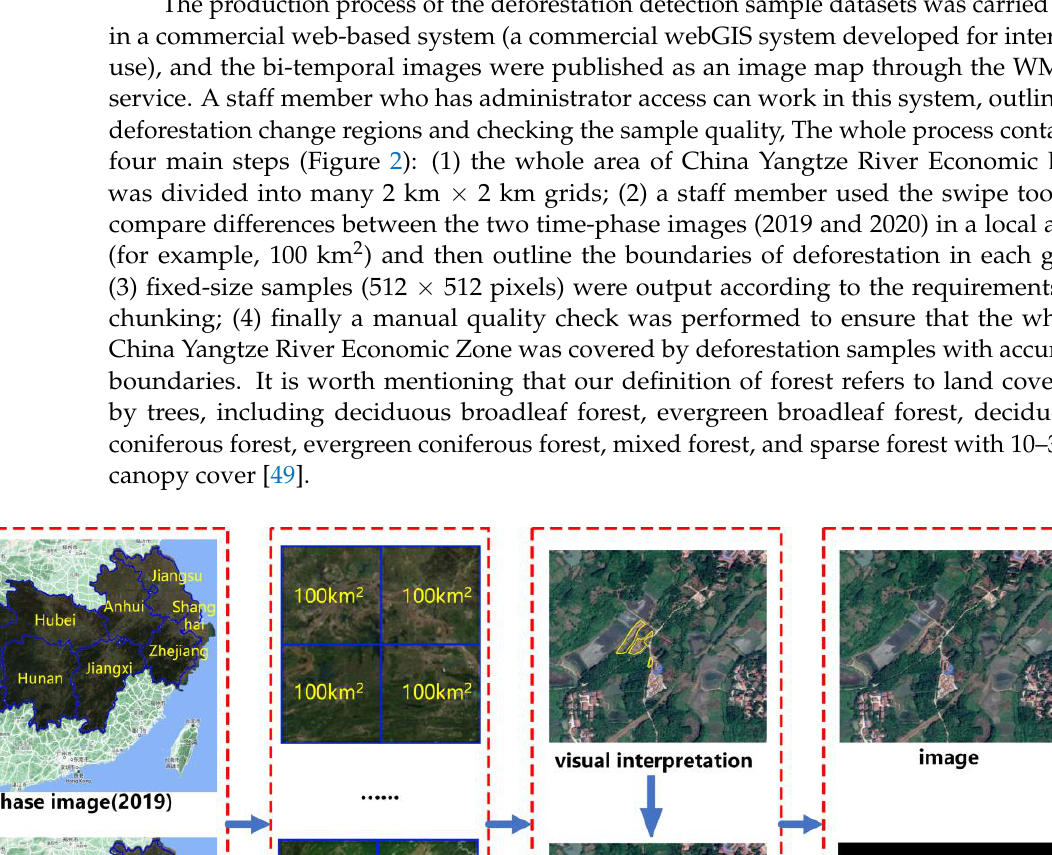
Figure 3. Deforestation detection dataset. To reasonably evaluate the scientificity and rationality of the deforestation detection dataset, we select some excellent change detection datasets for comparison, for example, the SYSU-CD dataset [50], which was generated for multi-class change detection, includ- ing roads, buildings, cropland, and water. The Google dataset [51] also provided a sample